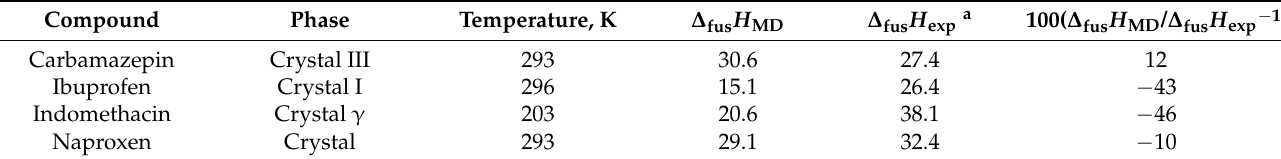
Table 3. Comparison of simulated and experimental fusion enthalpies ∆ fus H (kJ · mol − 1 ). Compound